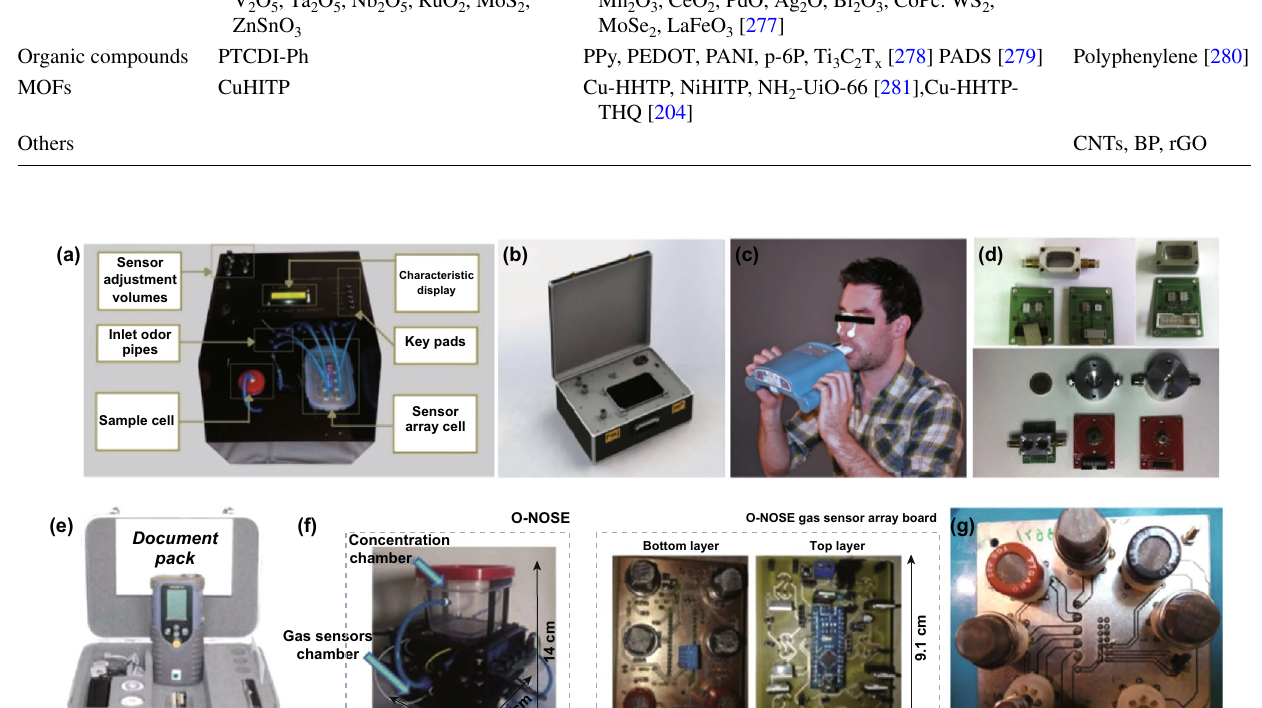
Table 7 Typical chemi-resistive materials for hybrid gas sensors Types of chemi- Types of conductivity resistive materials